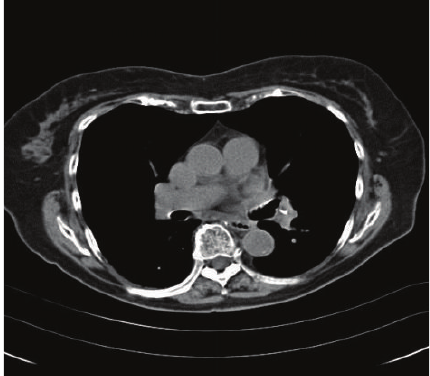
Figure 2: Computed tomography of chest without contrast depict- ing a filling defect in the branch of left pulmonary